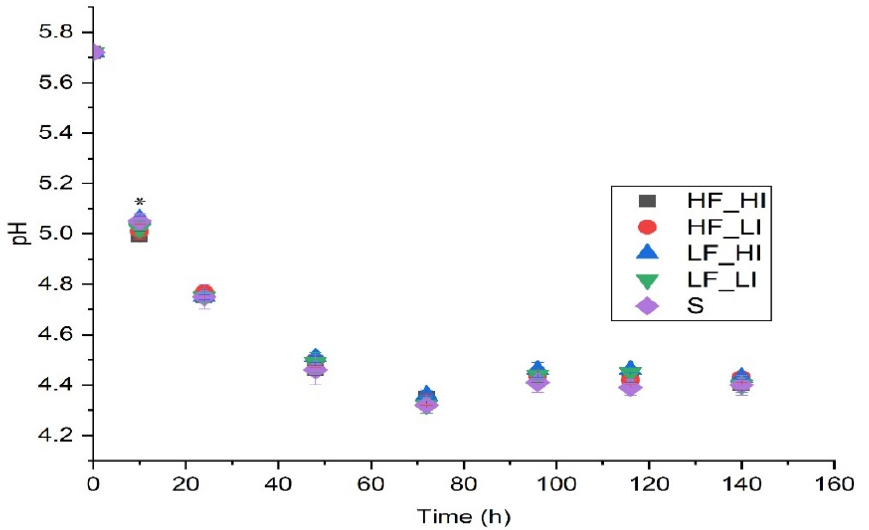
Figure 3. Change in pH during fermentation for five sound treatments. Low-frequency and low- intensity (LF_LI); low-frequency and high-intensity (LF_HI); high-frequency and low-intensity (HF_LI); high-frequency and high-intensity (HF_HI); silence (S). * Significant differences observed at 10 h. Results shown are means of three fermentation replicates ± standard deviation.